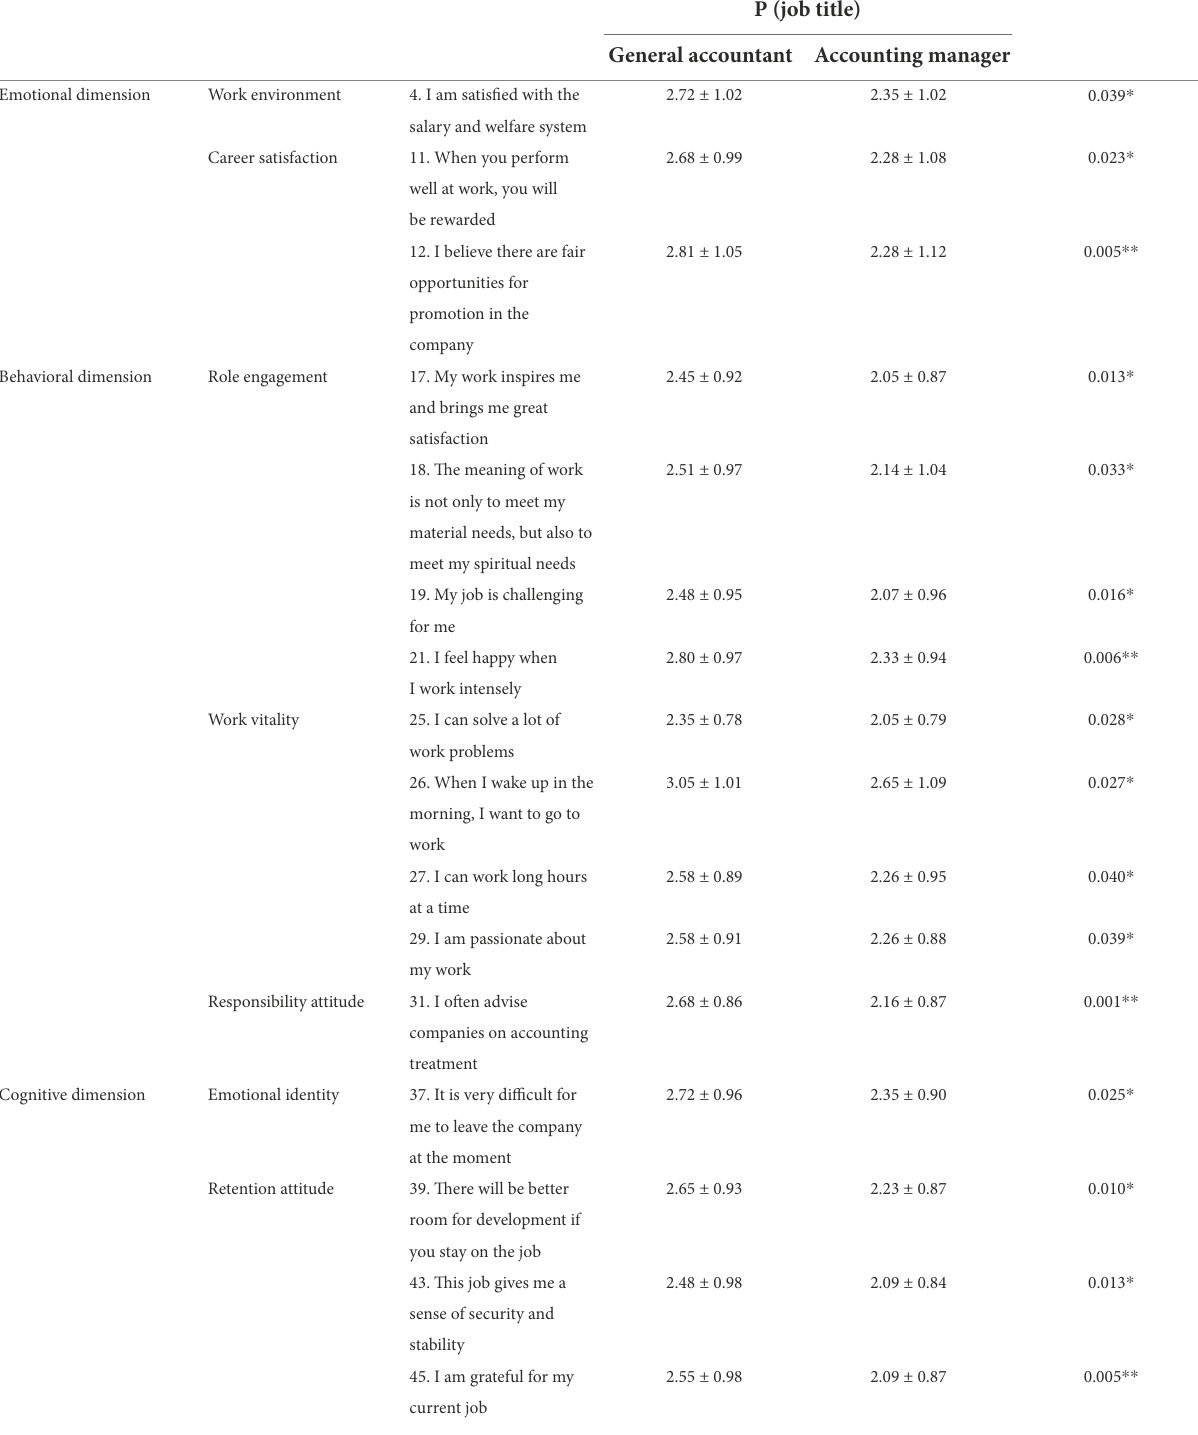
TABLE 5 Analysis results of job T -test. Dimension Factor Test